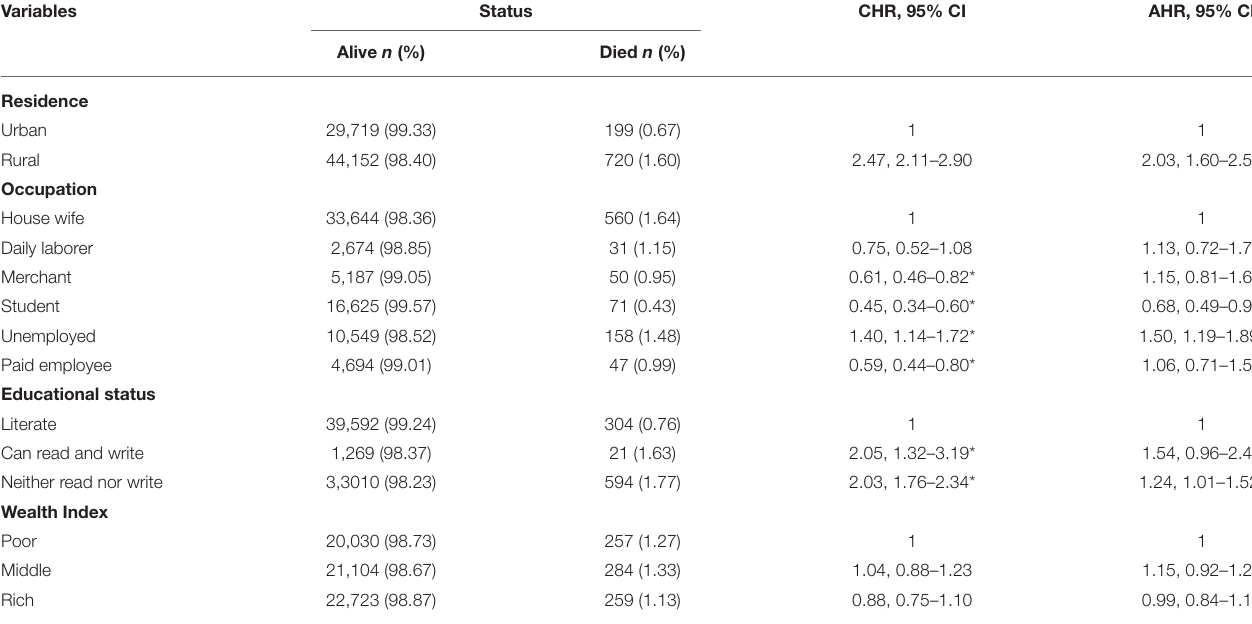
TABLE 3 | Crude and adjusted Cox regression of hazard of death among women reproductive age in Kersa HDSS, Eastern Ethiopia from 2008 to 2019.